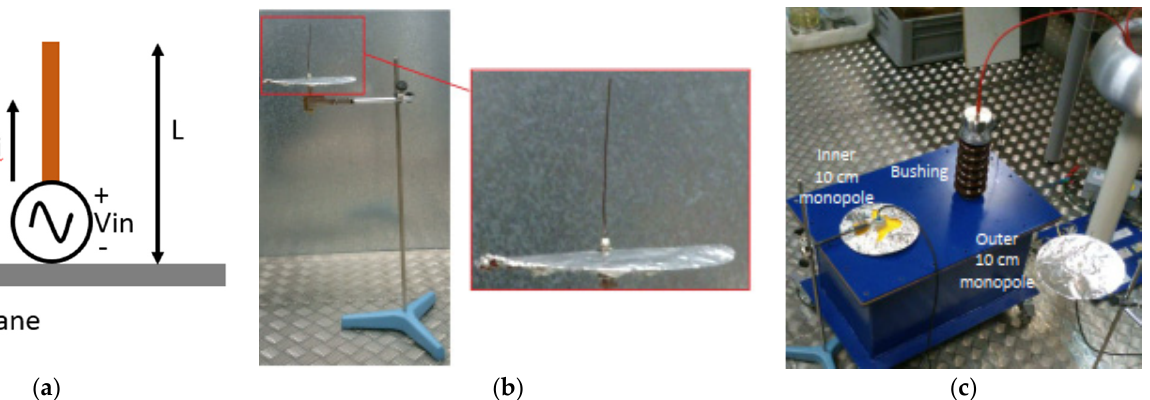
Figure 14. The monopole antenna: ( a ) basic design, ( b ) the designed monopole antenna with ground plane [105], and ( c ) two antennas inside and outside the tank to measure surface PD from the bushing insulator [105].